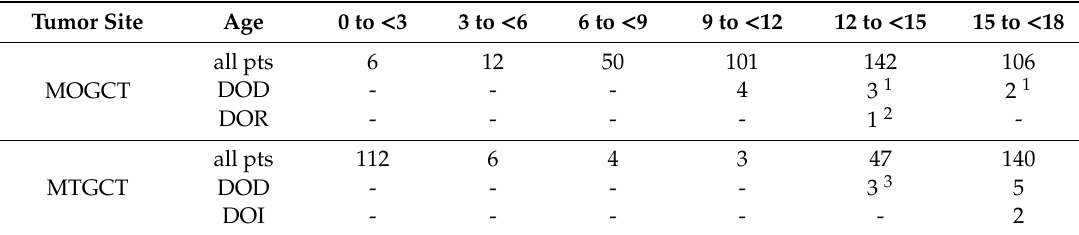
Table 2. Patients (pts) with MGCT dead of disease (DOD), lethal infection (DOI), or other reason (DOR) in respect to the six age